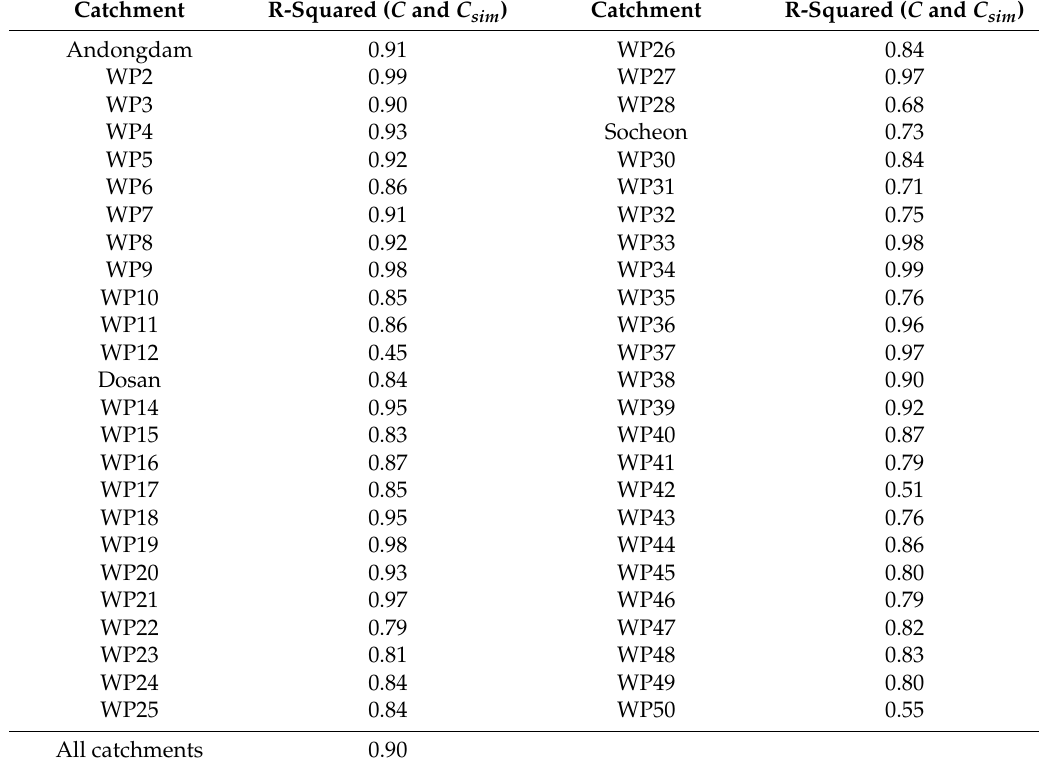
Table 1. R-squared values for the runoff coefficient ( C ) and simulated runoff coefficient ( C sim ) values. Catchment R-Squared ( C and C sim ) Catchment R-Squared ( C and C sim )